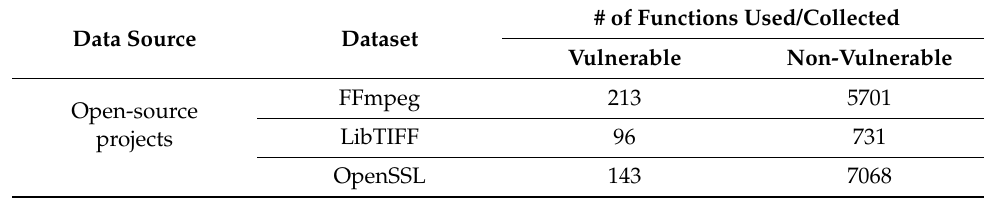
Table 1. The data set used in the experiments.